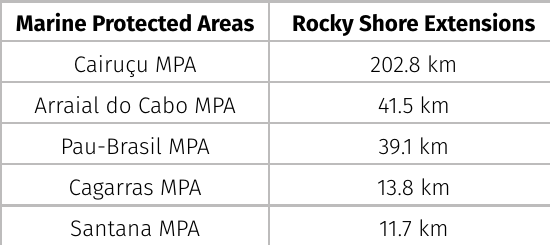
Table III. Rocky shores extension for all the analyzed Marine Protected